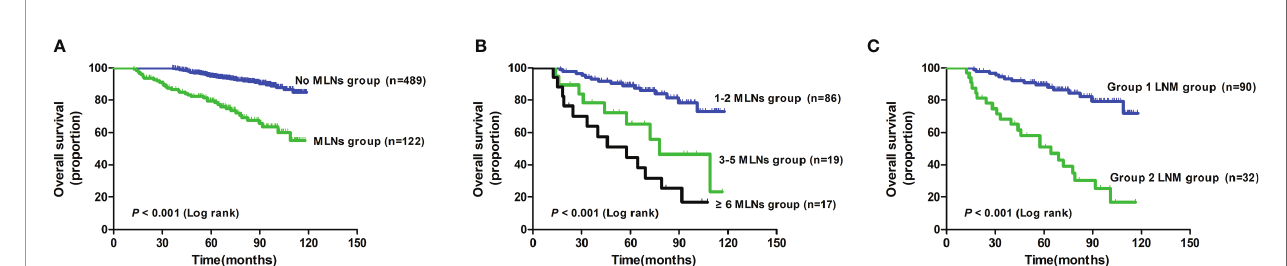
FIGURE 1 | Survival Analysis of 611 EGC patients. (A) Survival analysis of groups with or without MLNs. (B) Survival analysis of groups based on the number of MLNs. (C) Survival analysis of groups based on group 1 and 2 LNM. MLNs, metastatic lymph nodes; LNM, lymph node